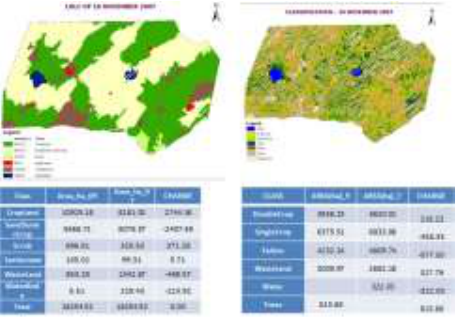
Figure-4- Change Matrix LUC between 2000 to 2005